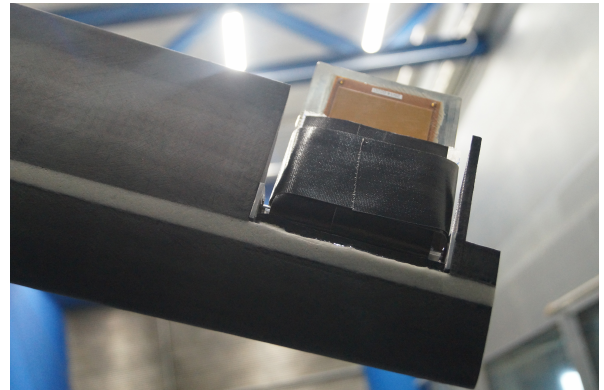
Figure 7. Photograph of